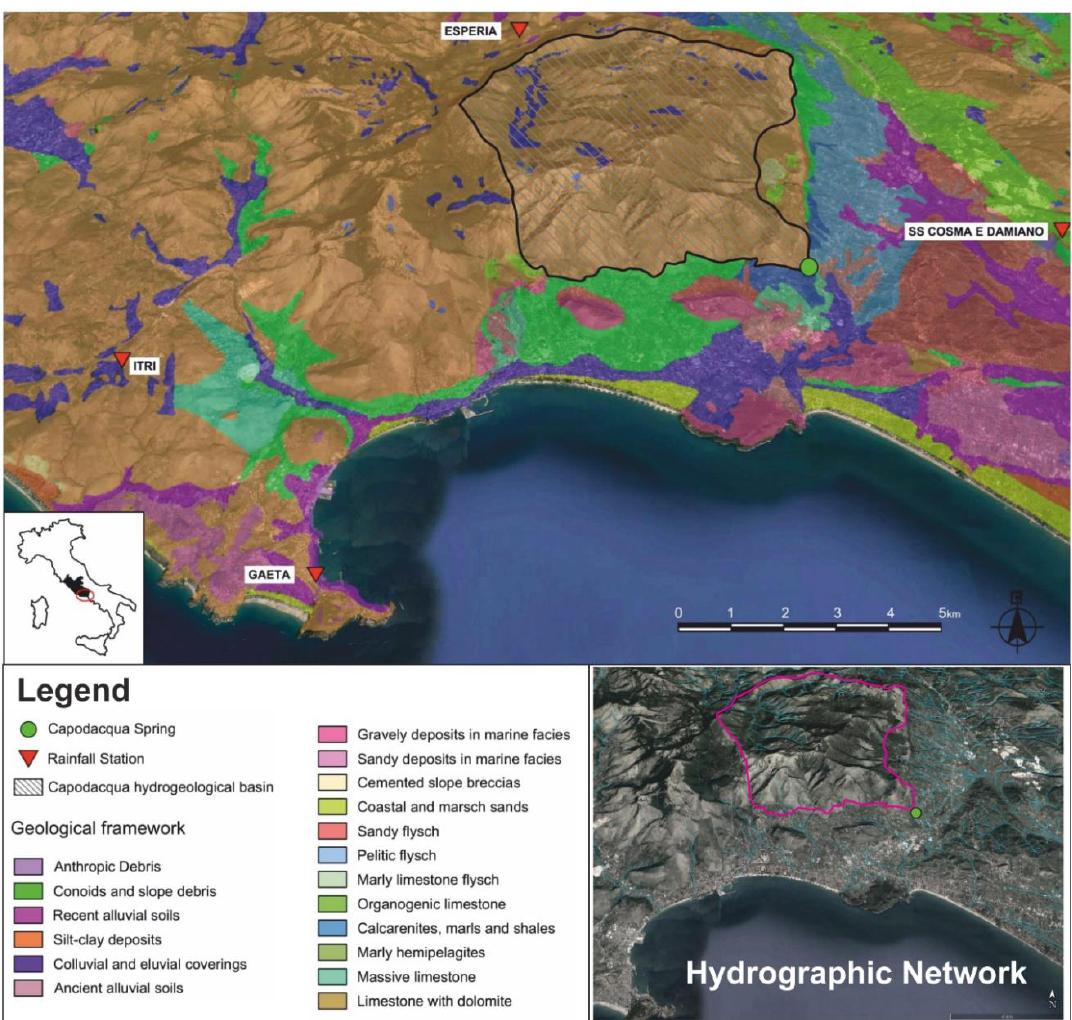
Figure 2. Geological framework and hydrographic network, based on Sappa et al., 2019 [15].